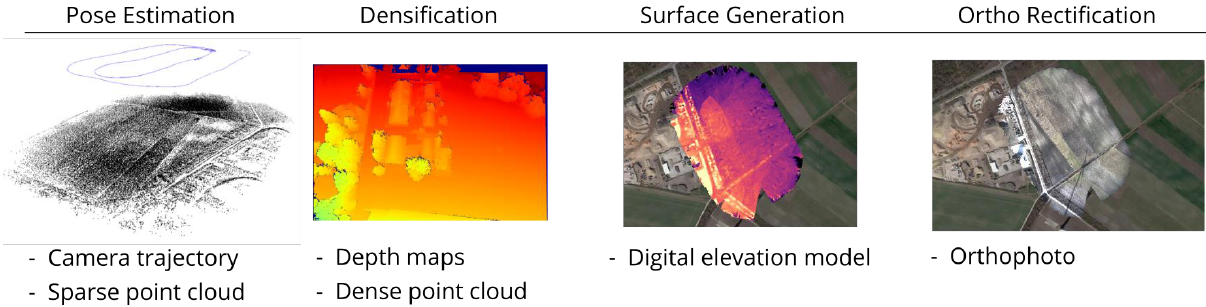
Figure 2 OpenREALM provides exports for most traditional photogrammetry data products. It allows for the extraction of the camera trajectory in 3D, sparse and dense point clouds, depth maps for all keyframes, 2.5D digital elevation models and orthomosaics, all of which are fully georeferenced.